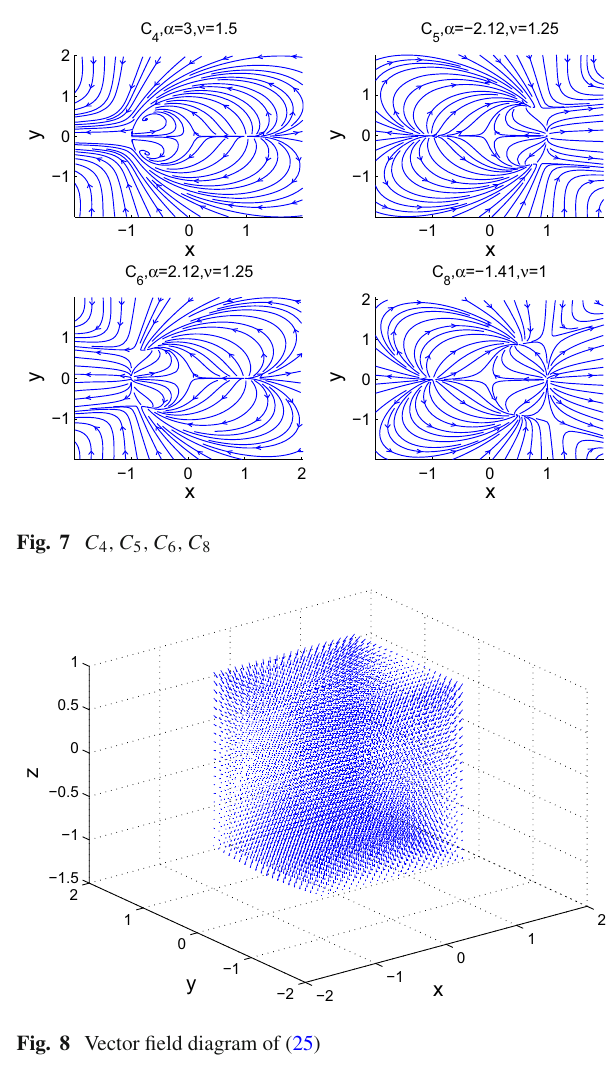
Fig. 8 Vector field diagram of